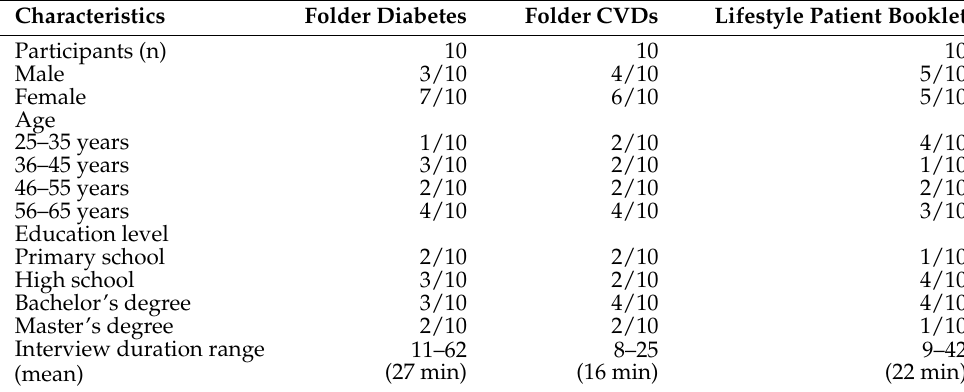
Table 2. Overview of the participants’ characteristics.